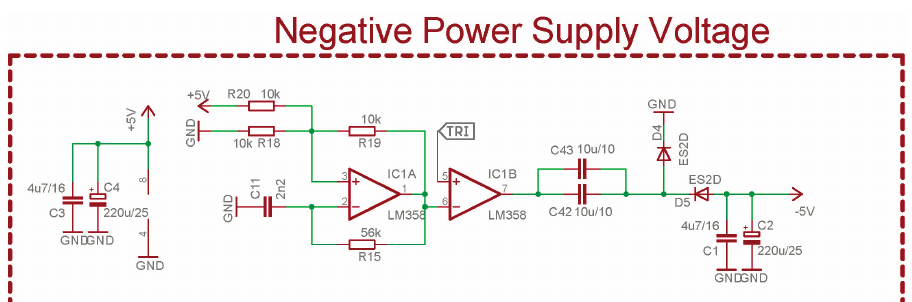
Figure 4. Negative voltage power supply—charge